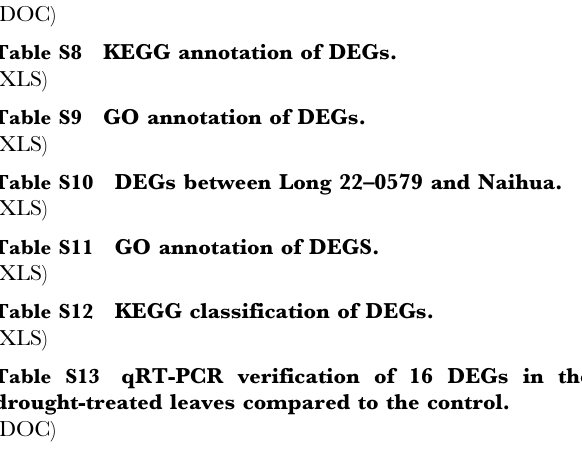
Figure S1 Length distributions of unigenes. Table S1 Classification and agronomic traits of two common bean cultivars. Table S2 Drought resistance index of each cultivar. Table S3 Summary of sequencing outputs. Table S4 Statistics of SSRs identified in common bean transcripts. Table S5 Frequency of di- and tri-nucleotide EST-SSR repeat motifs in the common bean. Table S6 Statistics for SNPs between Long 22–0579 and Naihua. Table S7 Annotation sources for the unigenes of the common bean. Table S8 KEGG annotation of DEGs. Table S9 GO annotation of DEGs. Table S10 DEGs between Long 22–0579 and Naihua. Table S11 GO annotation of DEGS. Table S12 KEGG classification of DEGs. Table S13 qRT-PCR verification of 16 DEGs in the drought-treated leaves compared to the